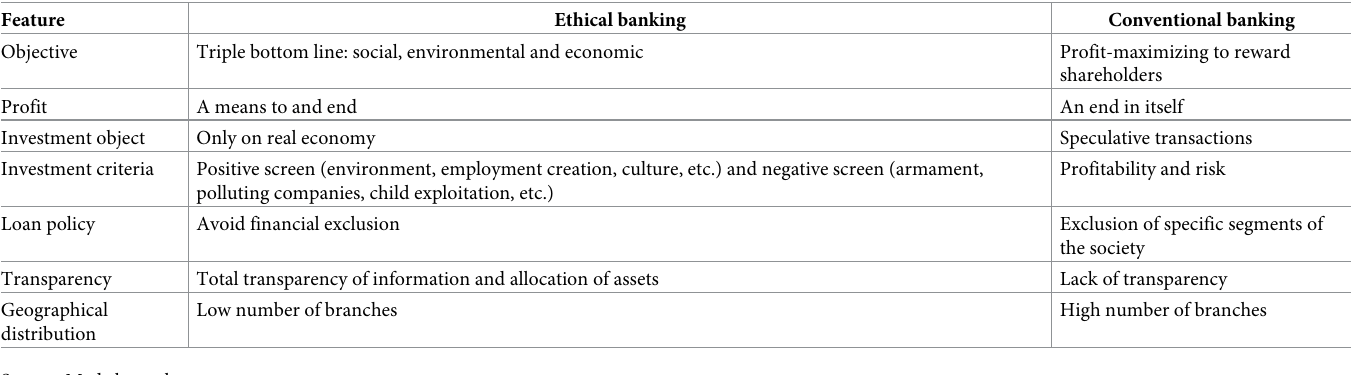
Table 1. Main differences between ethical and conventional